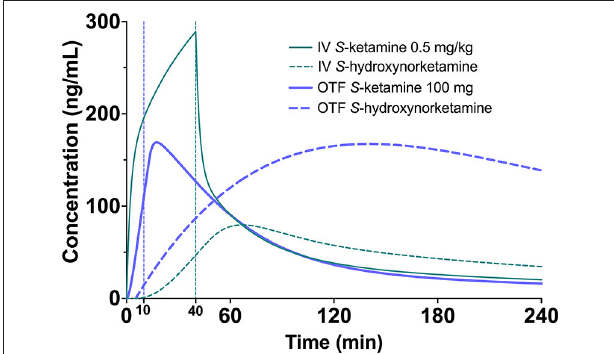
FIGURE 5 | Simulation showing the S -ketamine (continuous green line) and S -hydroxynorketamine (broken green line) concentration profiles following a 0.5 mg/kg S- ketamine infusion, given for 40min in a 70-kg individual. As comparator the equivalent concentrations are given following the 100mg S- ketamine oral thin film (blue continuous = S -ketamine, and broken blue line = S -hydroxynorketamine).